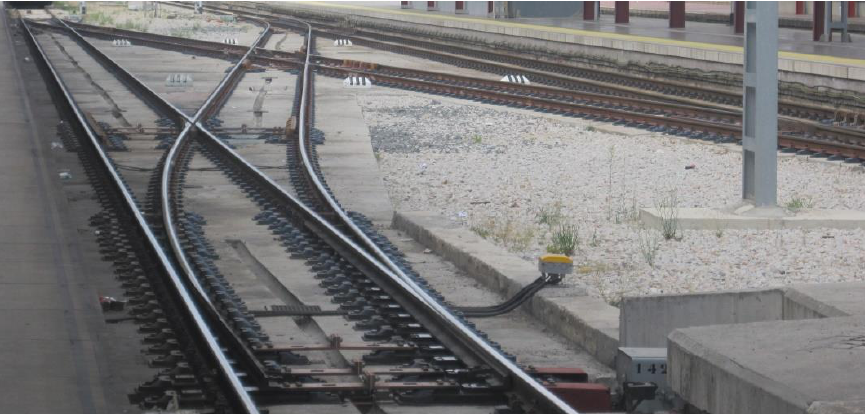
Figure 8. A scissors crossover. It consists of four turnouts and a crossing.